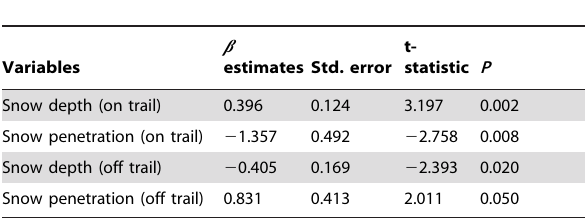
Table 2. Linear regression analysis testing for the effects of snow depth on snowmobile trails, snow penetration on snowmobile trails, snow depth off snowmobile trails, and snow penetration off snowmobile trails on the percent distance coyotes use a snowmobile trail.